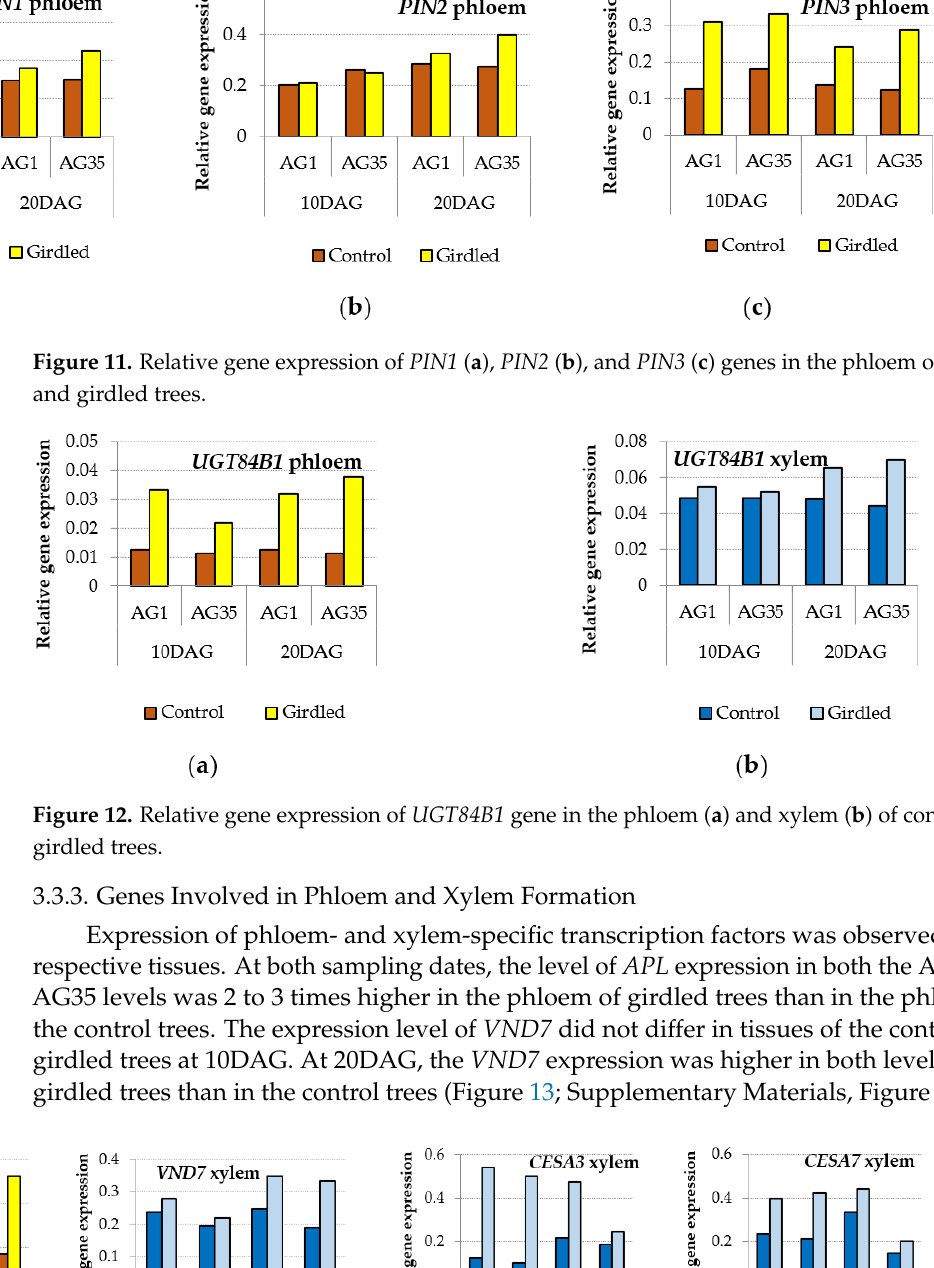
Figure 11. Relative gene expression of PIN1 ( a ), PIN2 ( b ), and PIN3 ( c ) genes in the phloem of control and girdled trees.